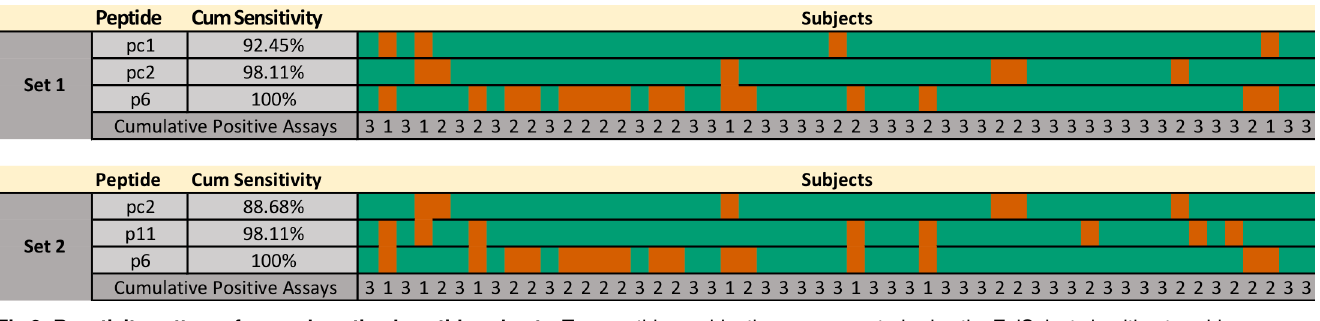
Fig 2. Reactivity pattern of example optimal peptide subsets. Two peptidecombinations were created using the EpiSelectalgorithmto achievea theoretical100%sensitivity, basedon data from the individualassays in S1 Table (53 Chagaspositive samples, 27 peptides). The figure shows positive (green) and negative (red) results for each combination of peptideand subject. The cumulativesensitivity is also indicated. For each set, the bottom row displaysthe cumulative number of positive results for each subject.